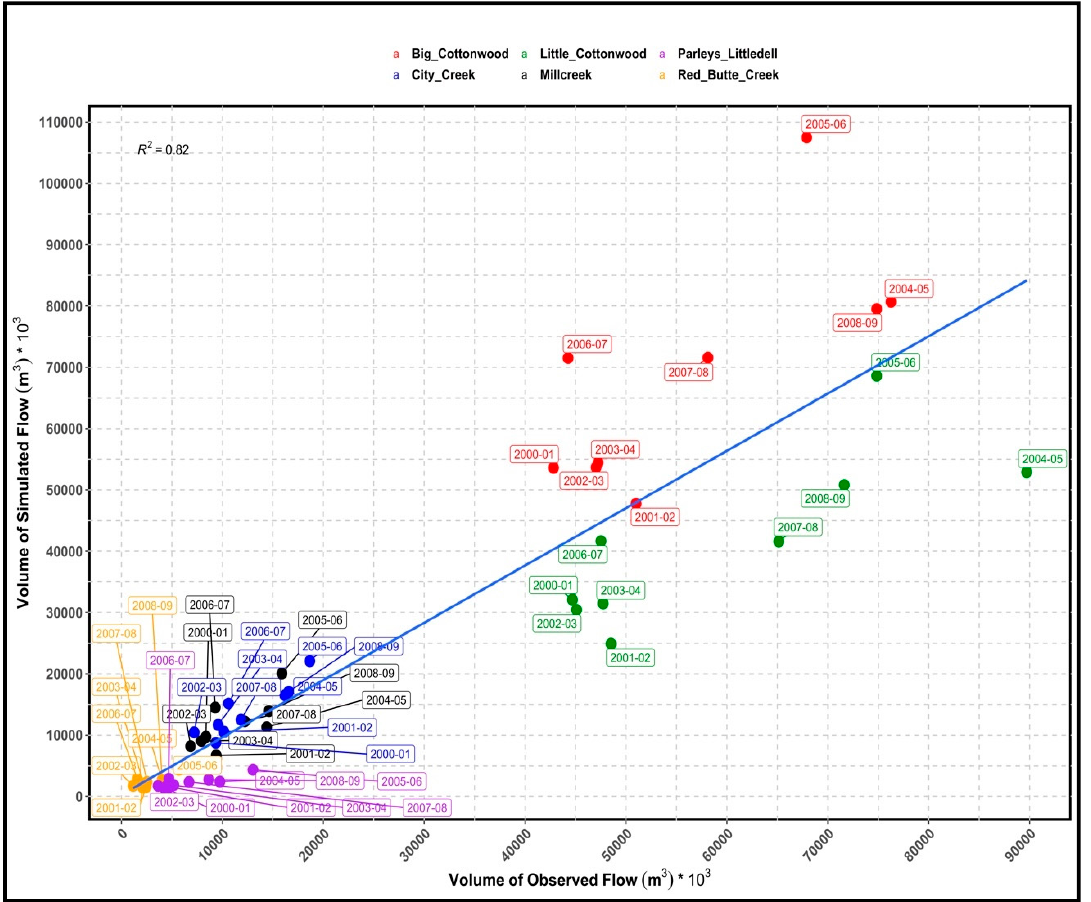
Figure 8. Observed and simulated annual volume of flow of the studied watersheds using dynamically downscaled climate projection for historical baseline period.